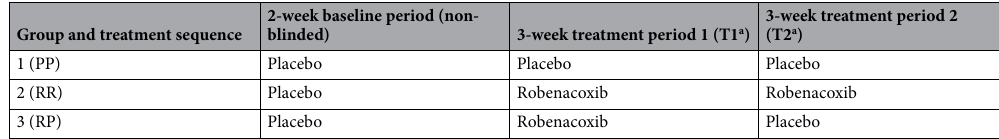
Table 9. Treatment group designations and treatments by period. P placebo, R robenacoxib. a Treatment periods T1 and T2 were